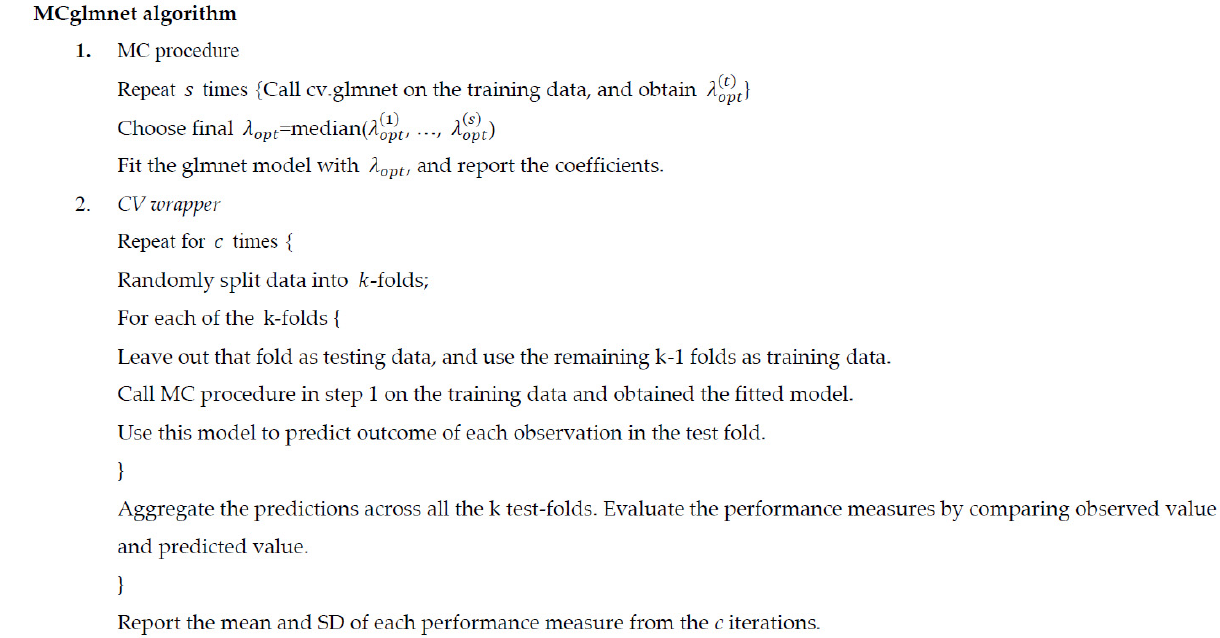
Figure 2. Outline of the MCglmnet algorithm.